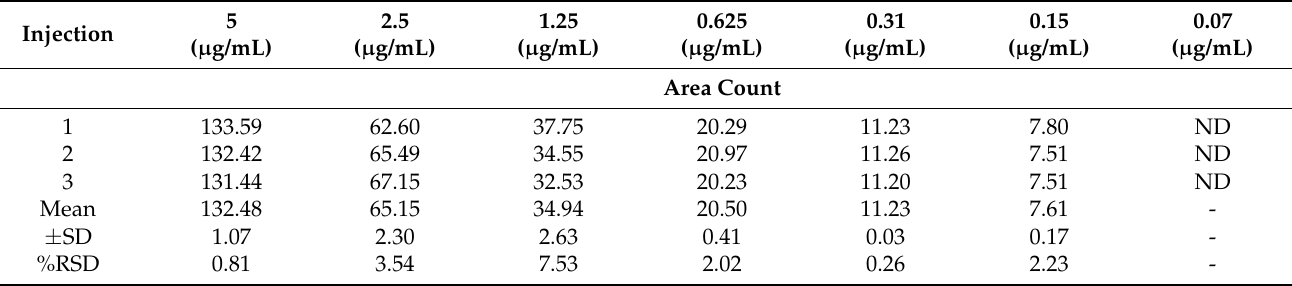
Table 4. Limit of detection and quantification.